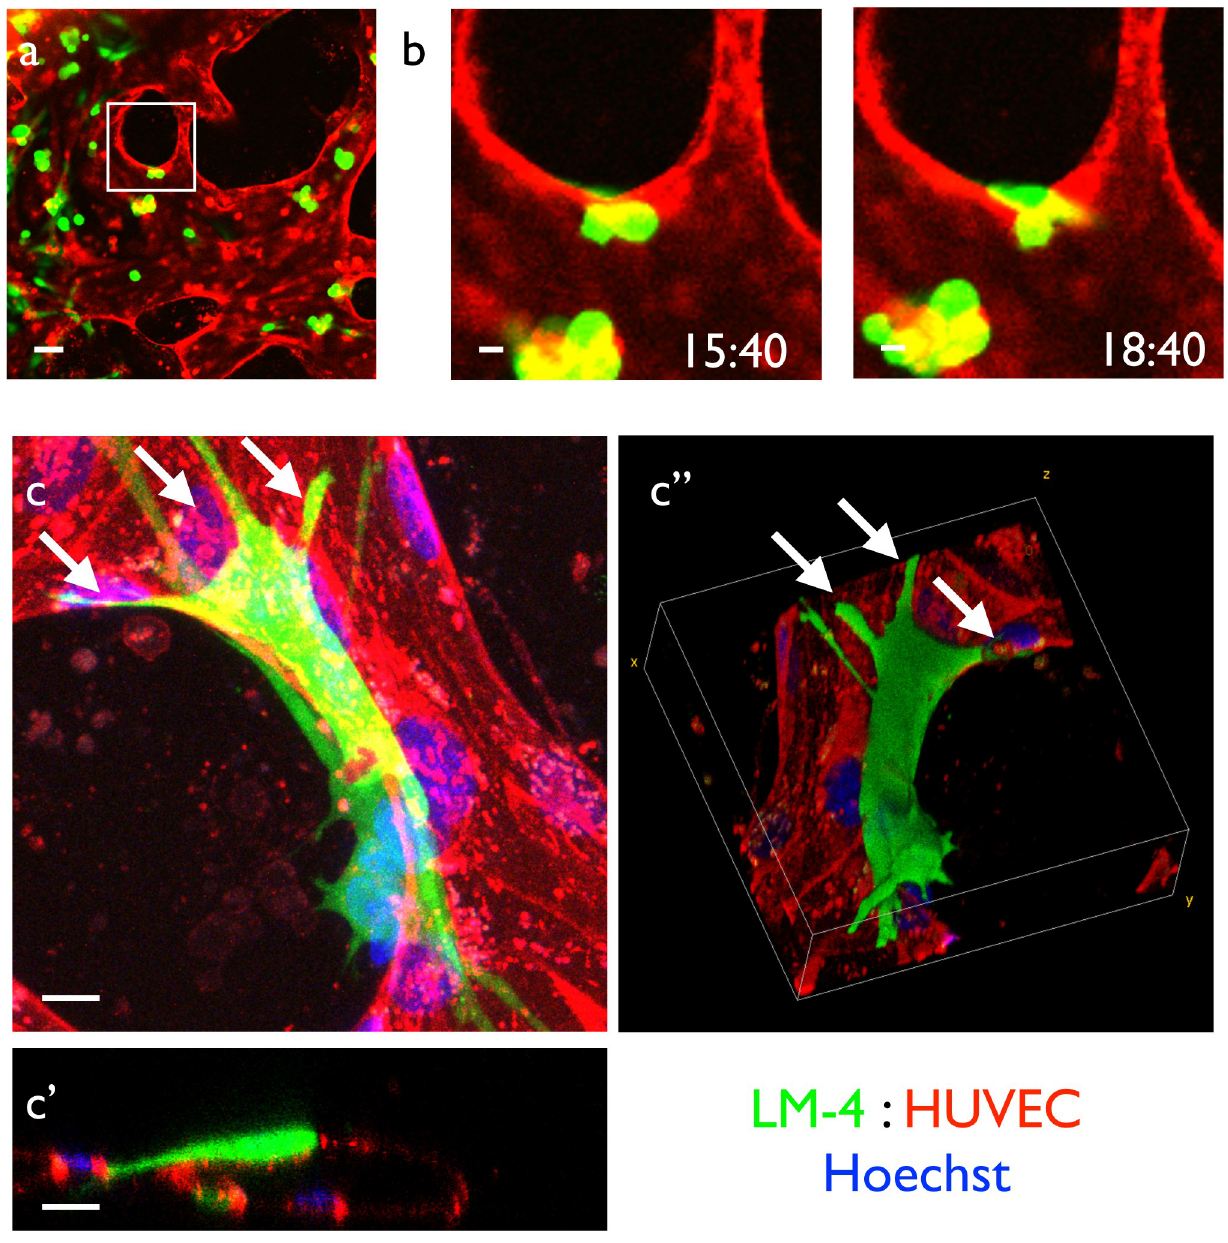
Fig 7. Reproduction of hematogenous metastasis of cancer cells from the capillary network. (a) LM4-GFP cells were introduced into the self- organized capillary network consisting of HUVECs visualized by UEA-1 lectin. (b) High magnification time-lapse view of (a). We observed cancer cells emigrating out of the blood vessels. (c) Detailed morphology of cancer cells on the endothelial cells. Emigrated LM4 cells attached to the blood vessel with highly polarized morphology and multiple protrusions. (c) Max projection image, (c’) orthogonal section, and (c’’) 3D-reconstructed image. White arrows: cancer cell protrusions. Scale bars: 50 μ m (a); 10 μ m (b, c).